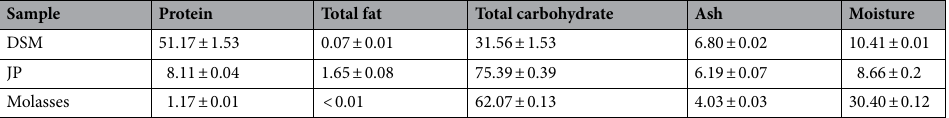
Table 1. Nutrient fraction (g/100 g) of defatted soybean meal (DSM) and jackfruit peel (DSM). Values were stated in mean ± standard deviation (n =